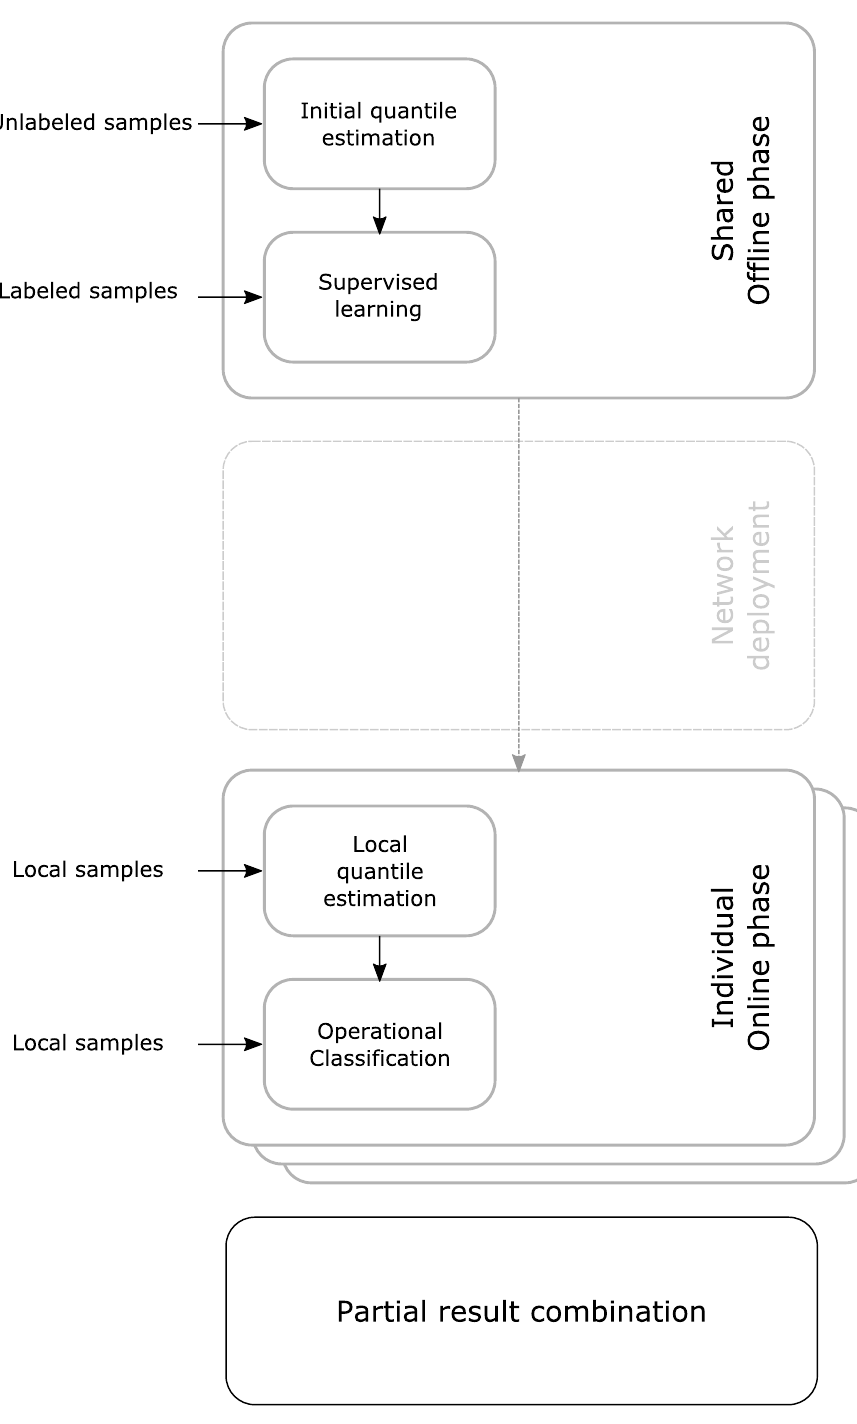
Figure 2. Block diagram of the phases of